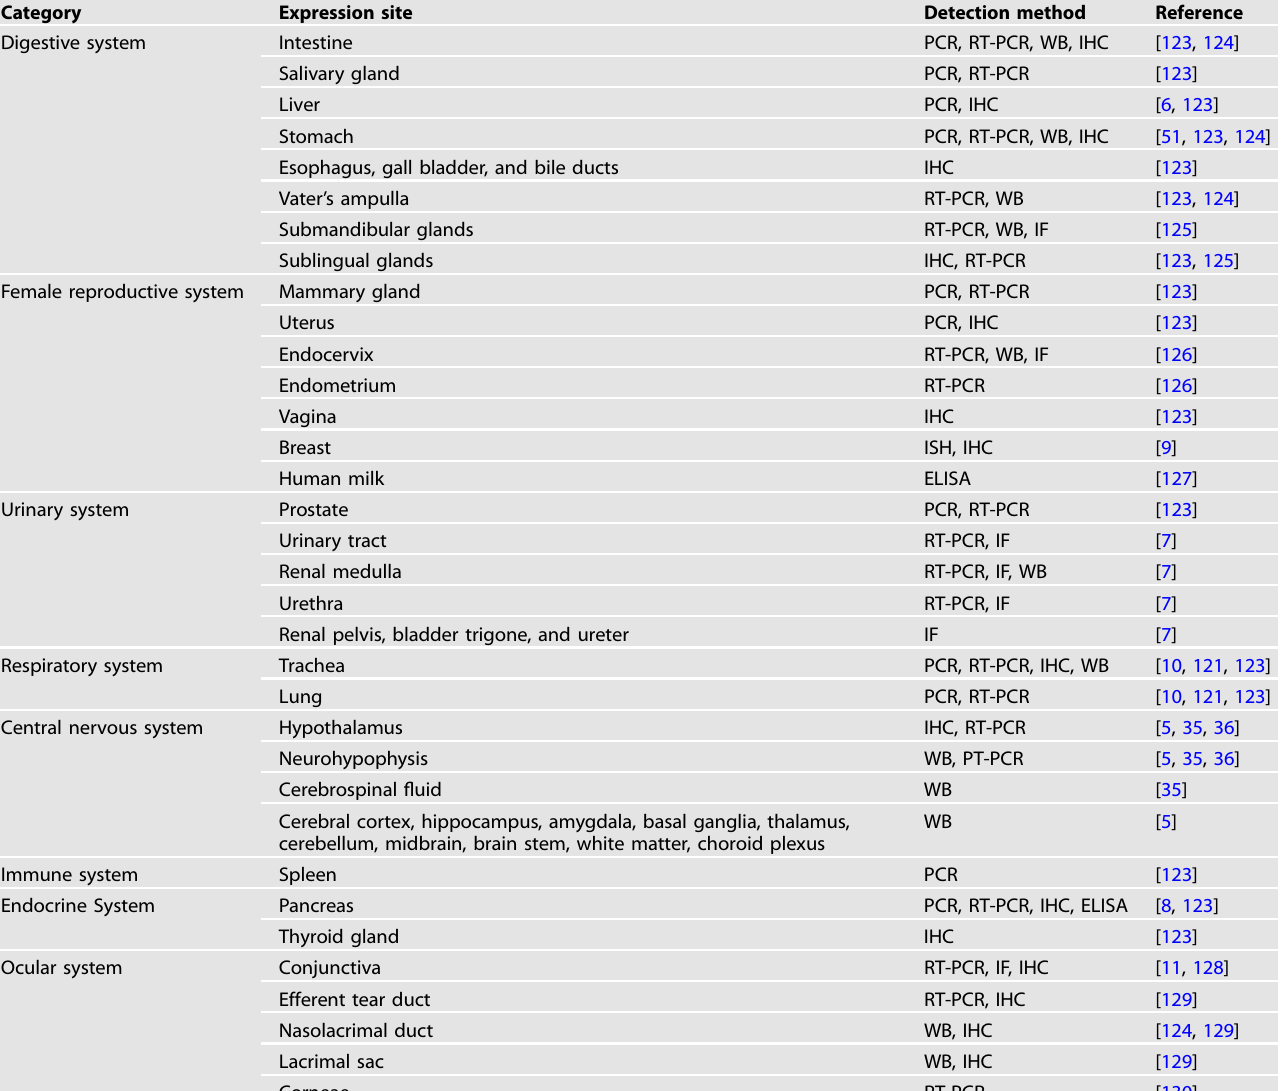
Table. 1. TFF3 distribution in samples from healthy